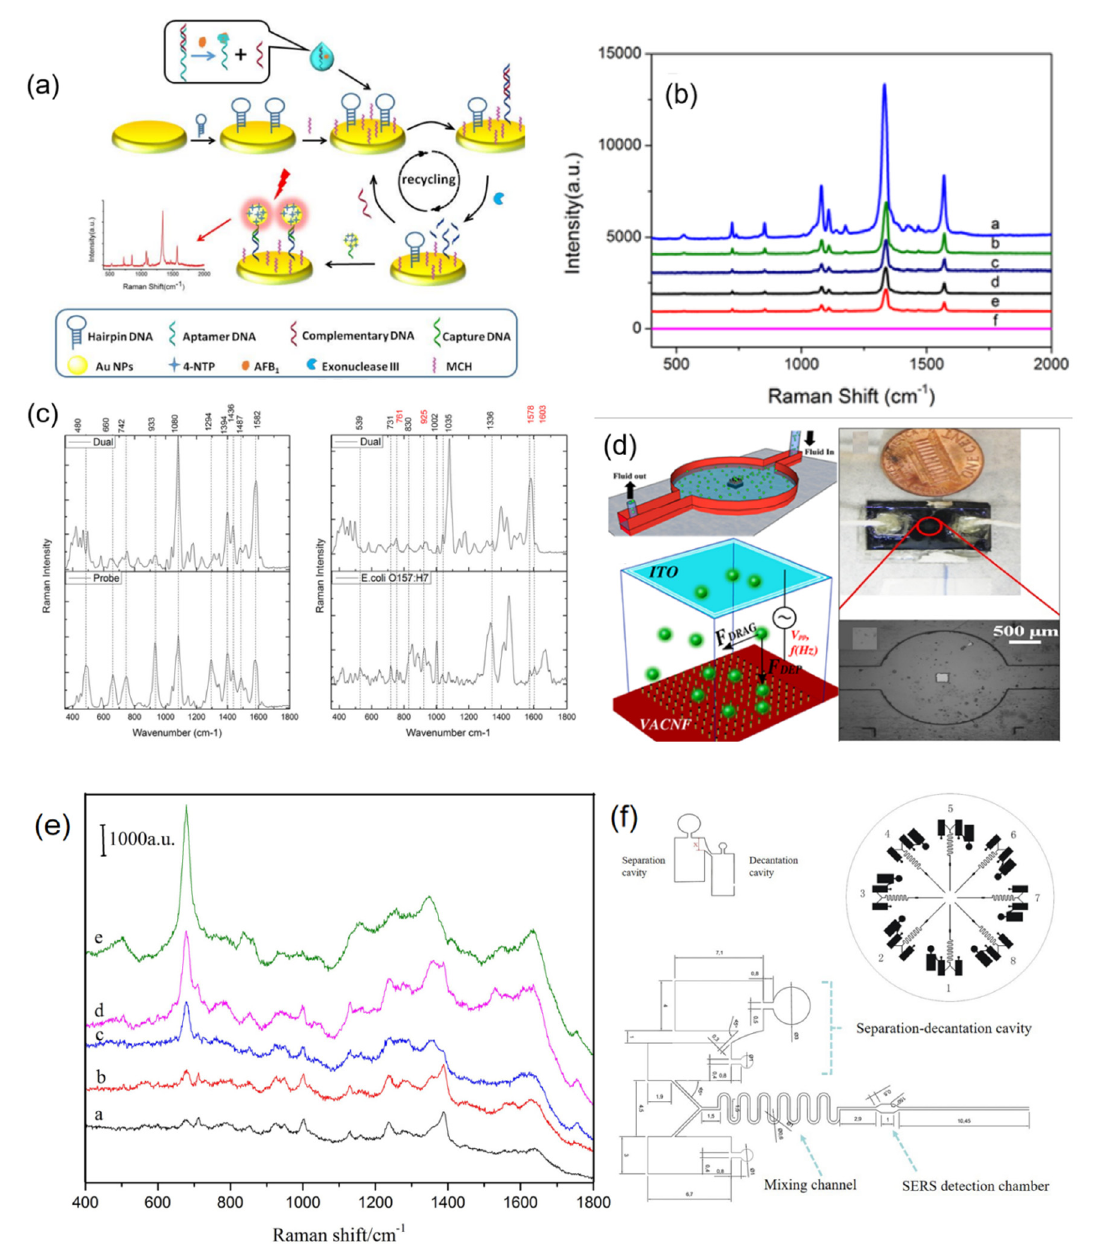
Figure 6. ( a ) Schematic illustration of the SERS sensor for aflatoxin B1 detection. ( b ) SERS spectra obtained in a series of control experiments. ( c ) SERS spectral results of bacterial samples using Nano- DEP microfluidic device. ( d ) Schematic illustration of Nano-DEP microfluidic device. ( e ) SERS spectra of different concentrations of creatinine solution in microfluidic SERS chip. ( f ) Unit structure and size of microfluidic SERS chip. ( a , b ) Reproduced with permission of Ref. [50], Copyright 2019,